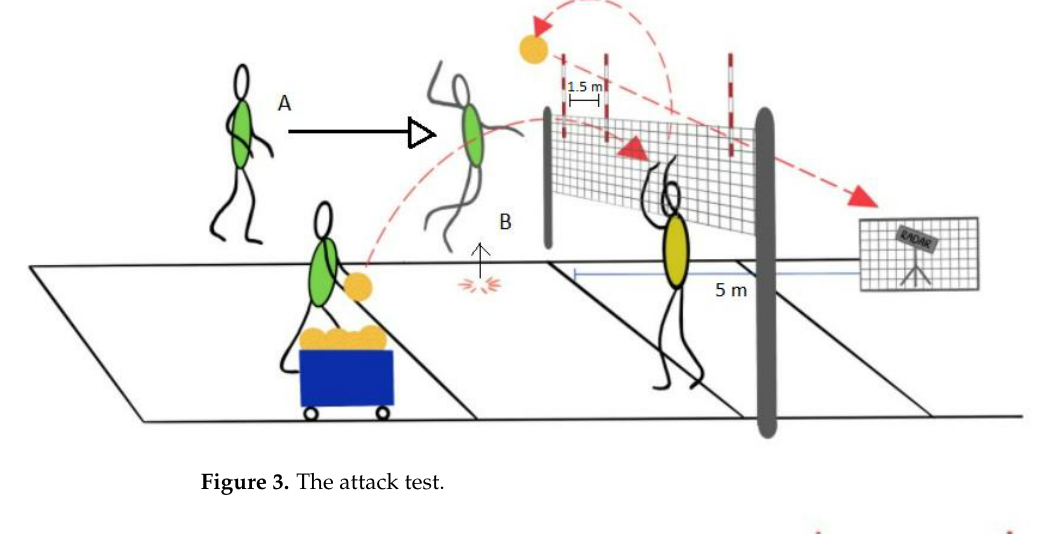
Figure 2. The maximal standing spike test.